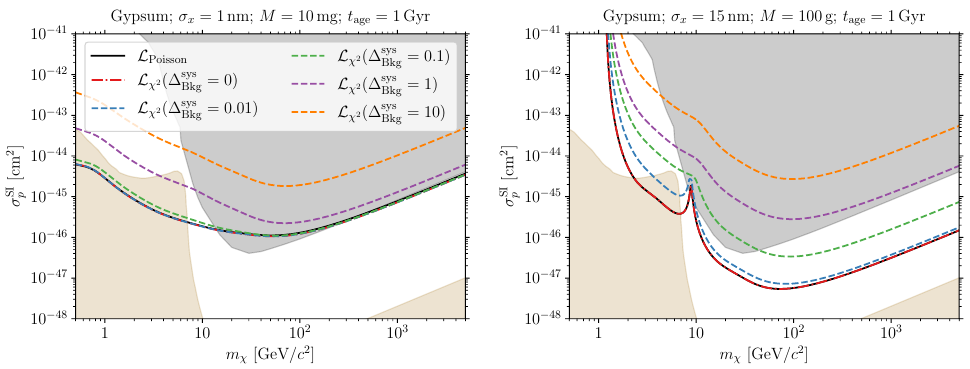
Figure 4. Projected 90% confidence level exclusion limits in a gypsum [Ca(SO 4 ) 2(H 2 O)] paleo- · detector in the high-resolution ( left ) and high-exposure ( right ) readout scenarios. The black solid lines show the projected limit using the Poisson log-likelihood (see Equation (9))in our maximum likelihood ratio test, Equation (12), while the dashed lines show the projected upper limit if we instead use a χ 2 distribution, Equation (14), for the log-likelihood. The differently colored dashed lines are for different assumptions regarding the relative systematic error of the background mod- eling parameterized by ∆ sys ; see Equation (15). The gray and sand-colored shaded areas indicate Bkg current upper limits and the conventional neutrino floor in a Xe-based direct detection experiment, respectively; see Figure 3. Colors and linestyles are the same in both panels. Note that in the left ( ∆ sys = 0 ) , and the ( ∆ sys = 0.01 ) lines are practically laying on top panel, the , the Bkg Bkg L Poisson L χ 2 L χ 2 of each